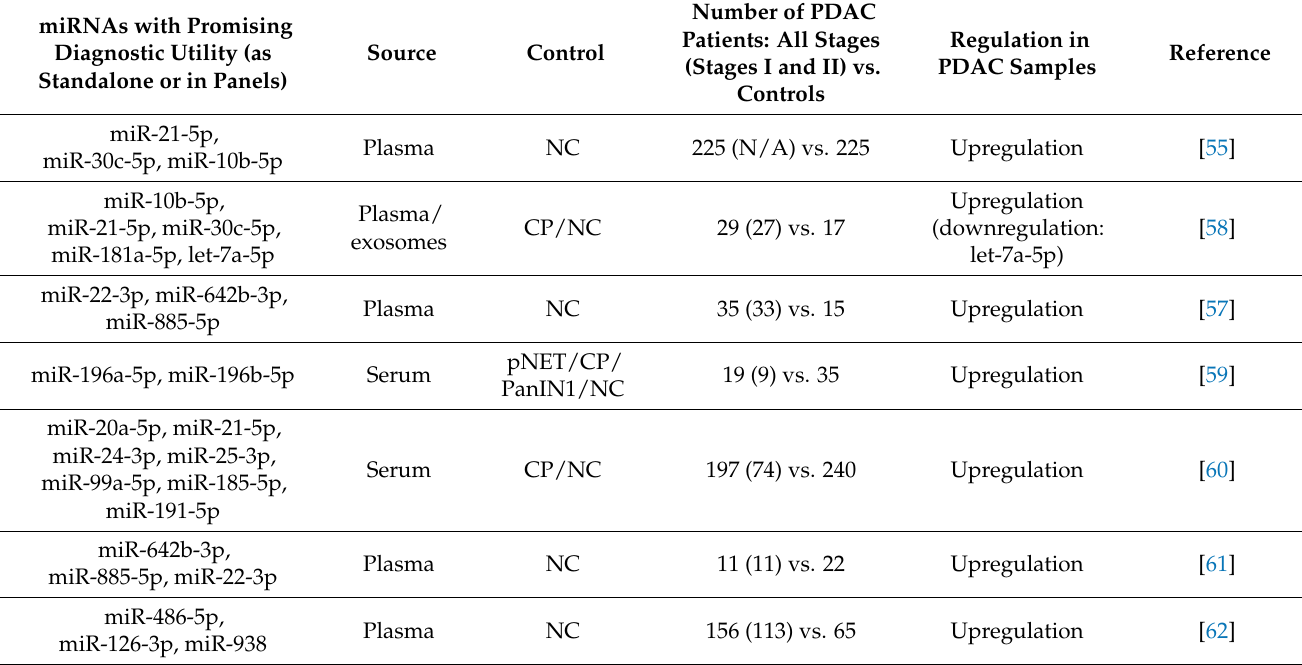
Table 1. Circulating miRNAs with a diagnostic significance in early-stage